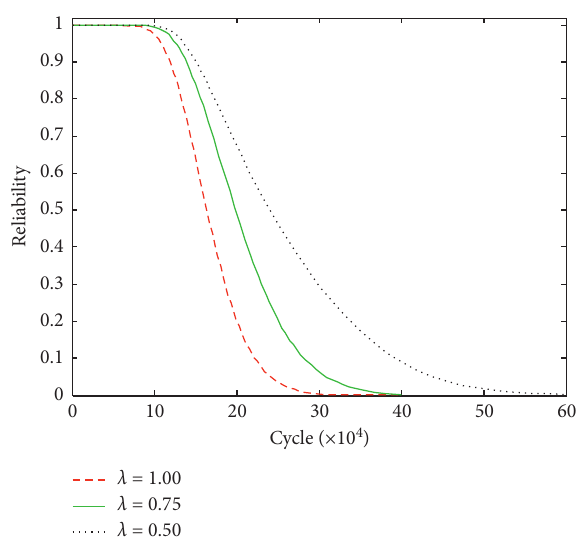
Figure 9: Sensitivity analysis of R ( t ) and on λ